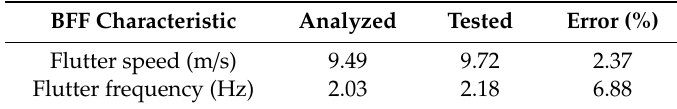
Table 5. Comparison of wind tunnel test results and theoretical analysis.